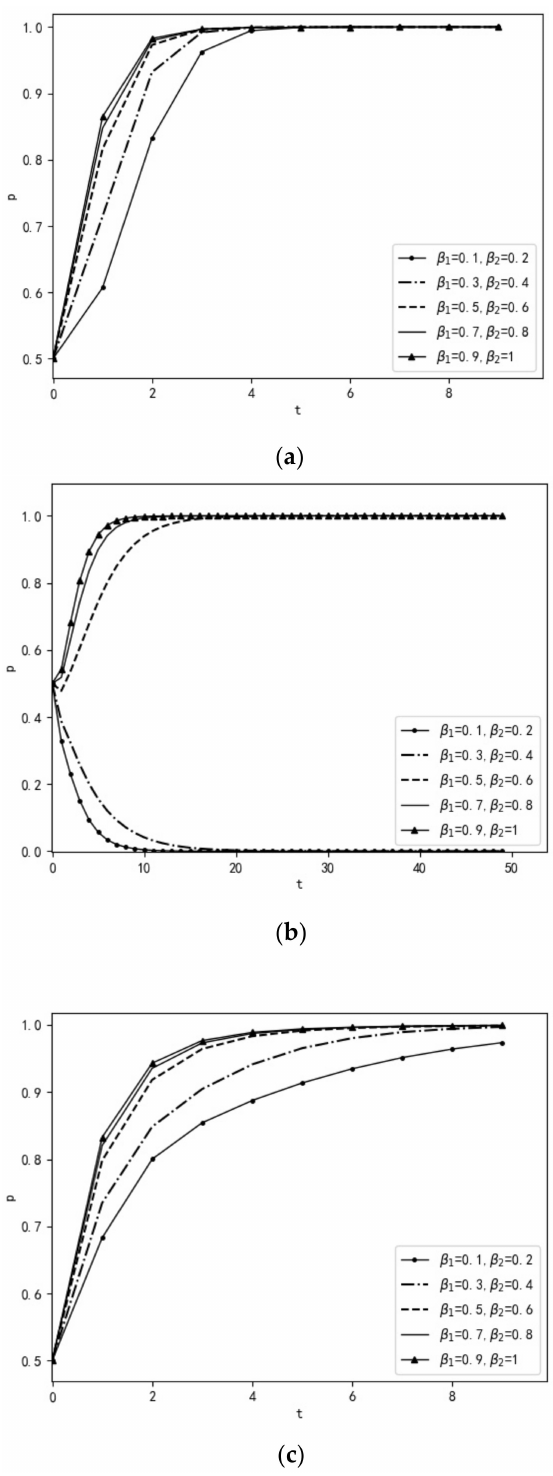
Figure 4. The effect of the probability of transformation from a latent individual to a supervisor on the tripartite strategy. ( a ) The impact of the probability of transition from a latent individual to a supervisor on the local government. ( b ) The impact of the probability of transformation from a latent person to a supervisor on the enterprises. ( c ) The effect of the probability of transformation from a latent individual to a supervisor on the